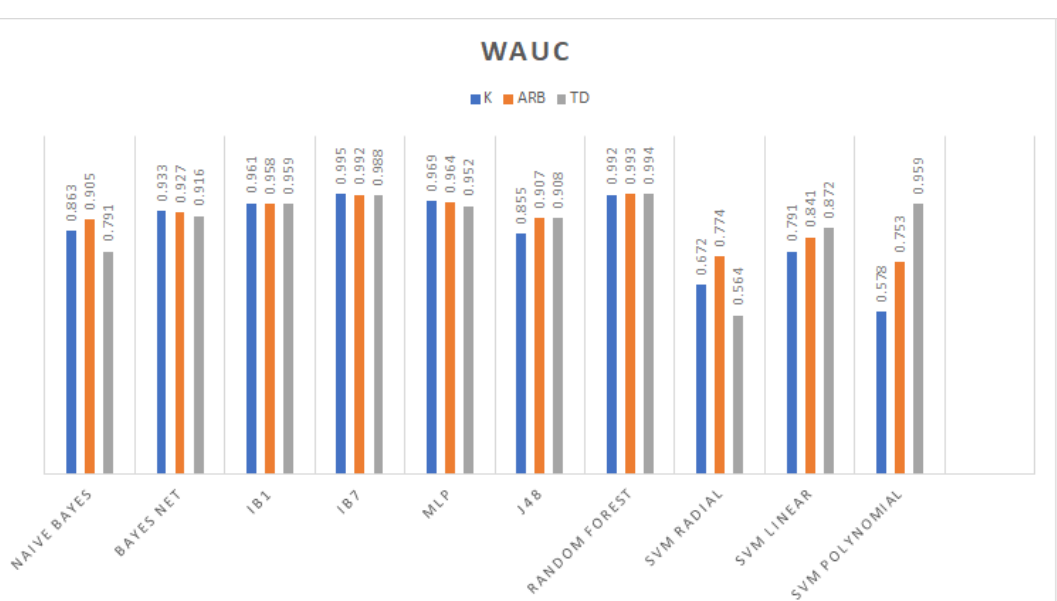
Figure 4. Accuracy rate achieved by the different classifiers.